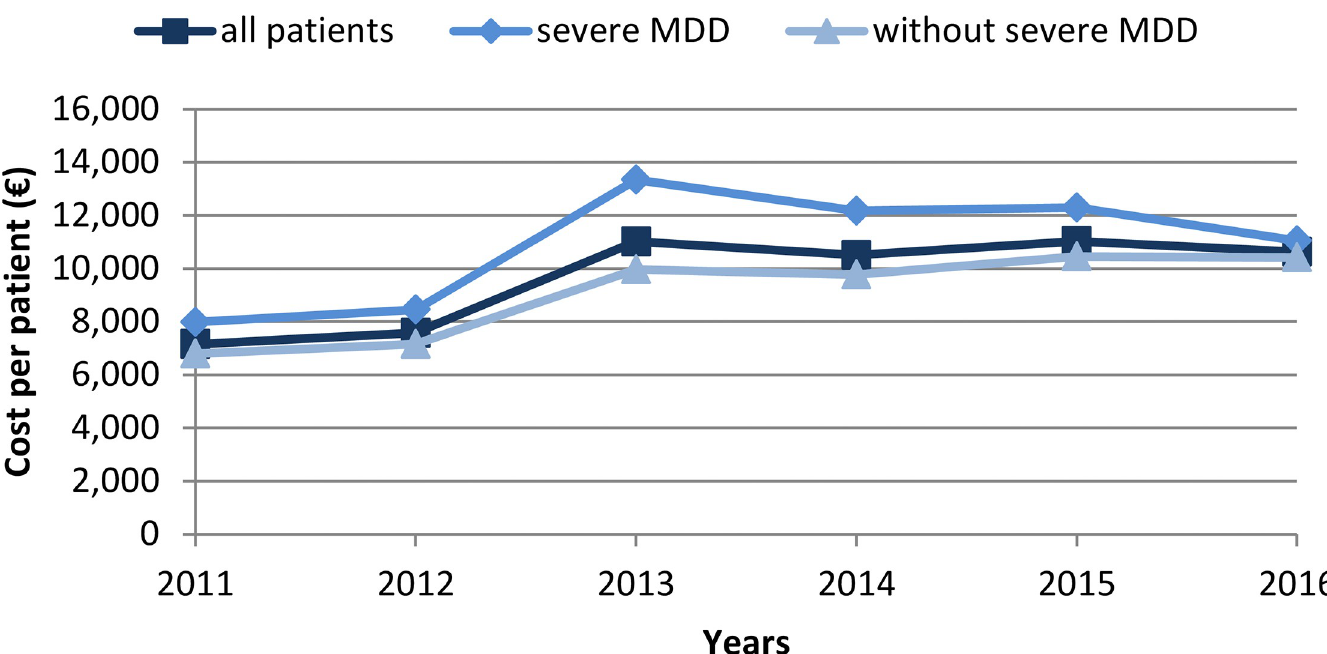
Fig 3. Annual medical costs of specialised care of depressive disorders considering all patients, patients with MDD and patients without